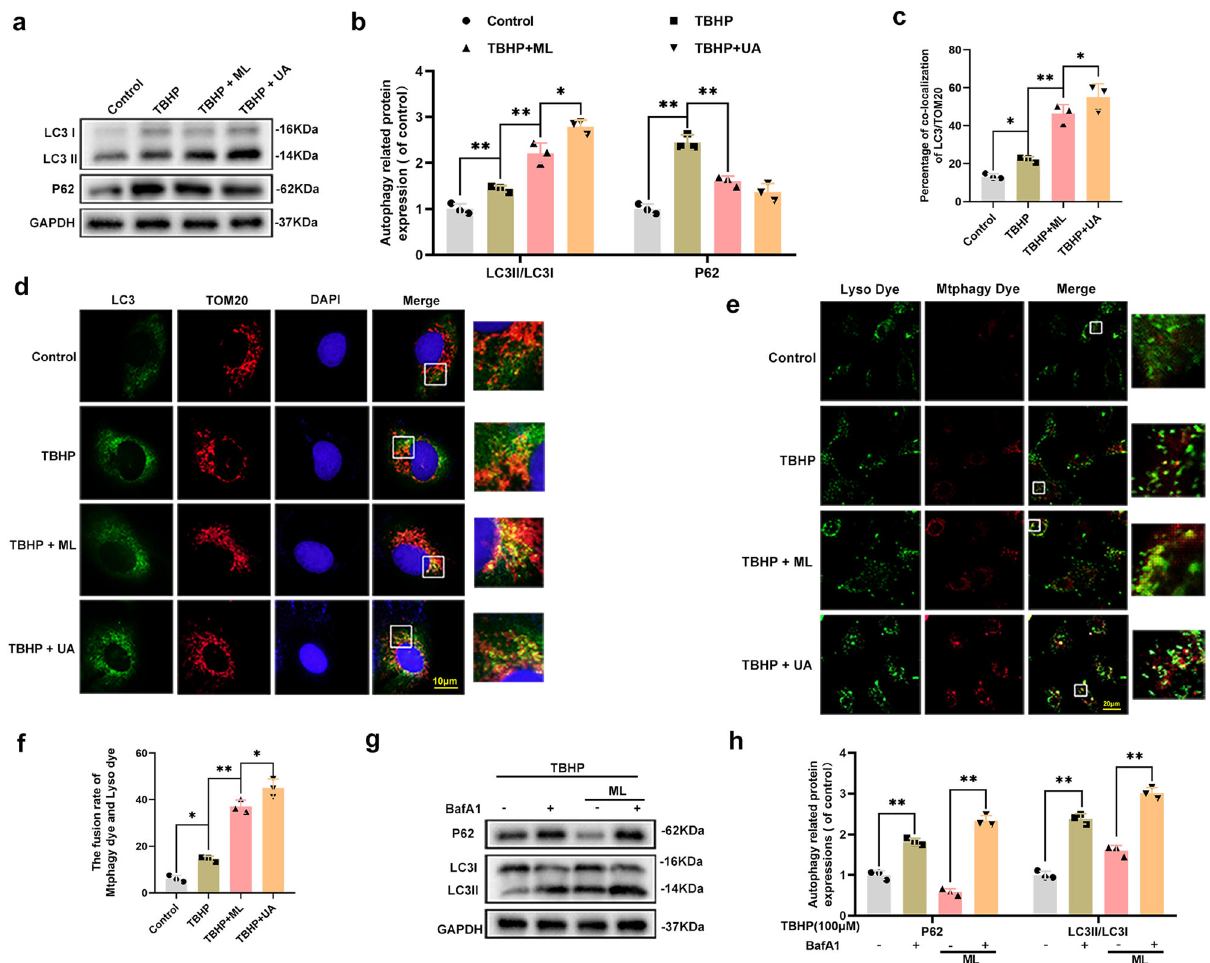
Fig. 2 ML promoted mitophagy and ameliorated TBHP-induced apoptosis in HUVECs. a , b Western blot showing the protein expression level of LC3 and P62 in HUVECs in the control, TBHP, TBHP + ML, and TBHP + UA groups. c , d Image of double-labeled staining of Tom20 and LC3 in HUVECs in the above groups (Green: LC3, red: TOM20, bar: 10 μ m). e , f Mitophagy detection kit detected the mitophagy in HUVECs in the above groups, wherein Mtphagy Dye staining indicates mitophagy, Lyso Dye staining indicates lysosomes, and yellow staining indicates co-localization of mitophagy and lysosomes. Scale bar: 20 μ m. g , h The expression level of LC3 and P62 in HUVECs in the presence and absence of Ba fi lomycin A1. All experiments were performed at least 3 times ( n ≥ 3). Data are presented as mean ± S.D. n = 3, ** P < 0.01, * P <